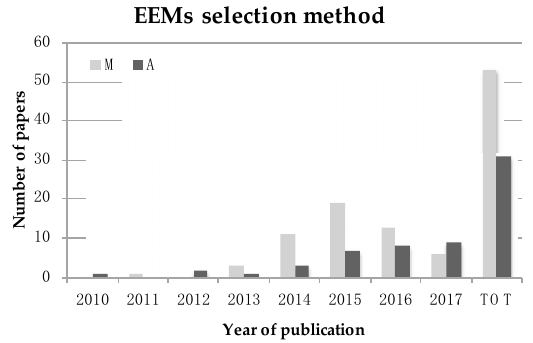
Figure 10. Methods for EEMs selection: manual (M) vs. automated (A) approach. Evolution of number of papers using the two approaches in the studied period (2010–2017).